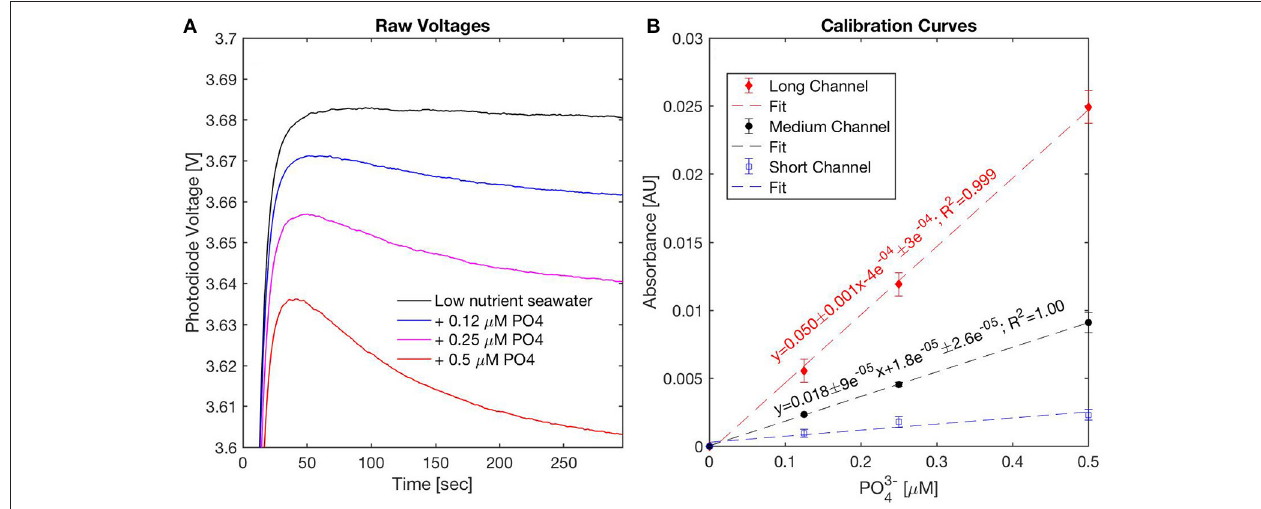
FIGURE 6 | Pre-deployment sensor performance evaluation using acidified low nutrient seawater spiked with 0.12, 0.25, and 0.5 µ M PO 3 − 4 . (A) Example voltages recorded during a 300s stopped flow period from the medium channel, (B) pre-deployment calibration curves for the long, medium, and short channels.